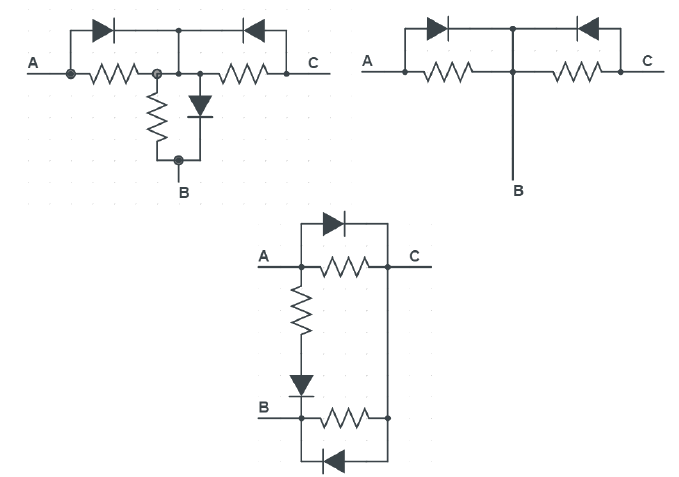
Fig. 5. ABC R-Diode circuit